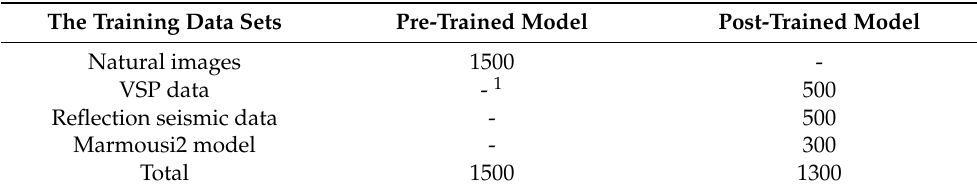
Table 1. Quantity of the training data sets allocations in the two